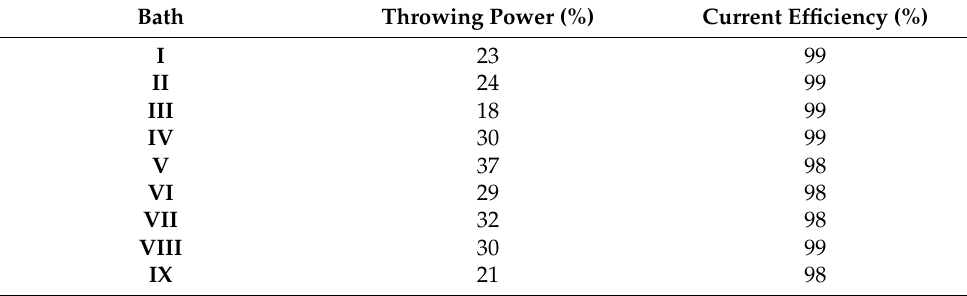
Table 3. Throwing power and cathodic current efficiency for the plating baths with additive concen- trations provided in Table 1 with a current density of 305 A m − 2 at the anode in the Haring–Blum cell (throwing power) and the cathode in the two-electrode cell (current efficiency). Base